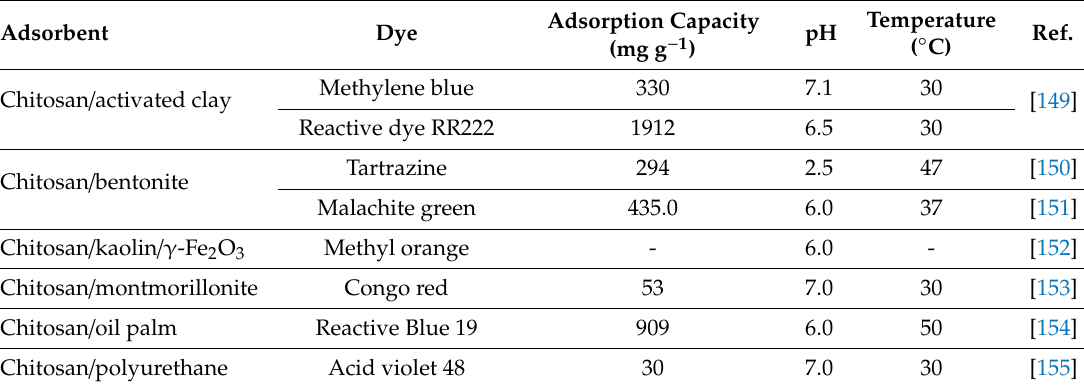
Table 9. Chitosan-based composites used in the adsorption of